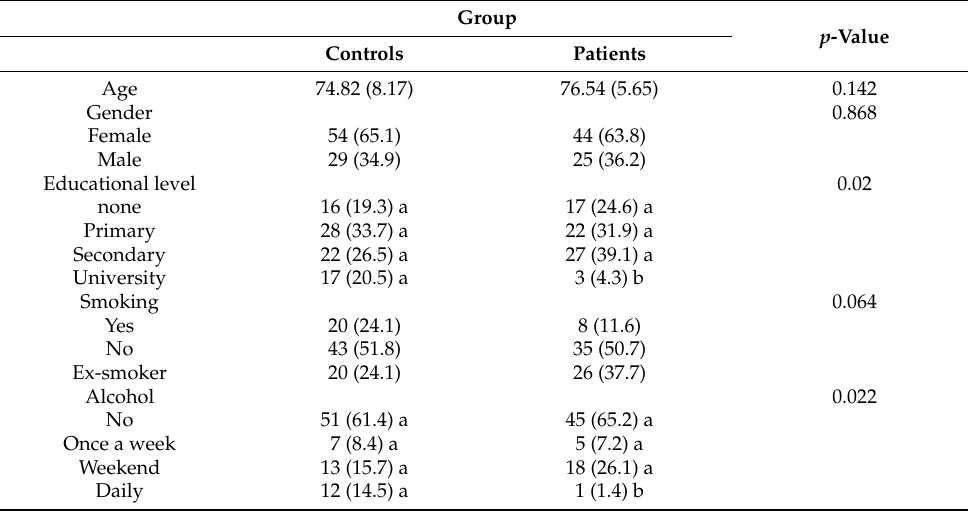
Table 1. Description and comparison of demographic variables and habits of the two study groups.